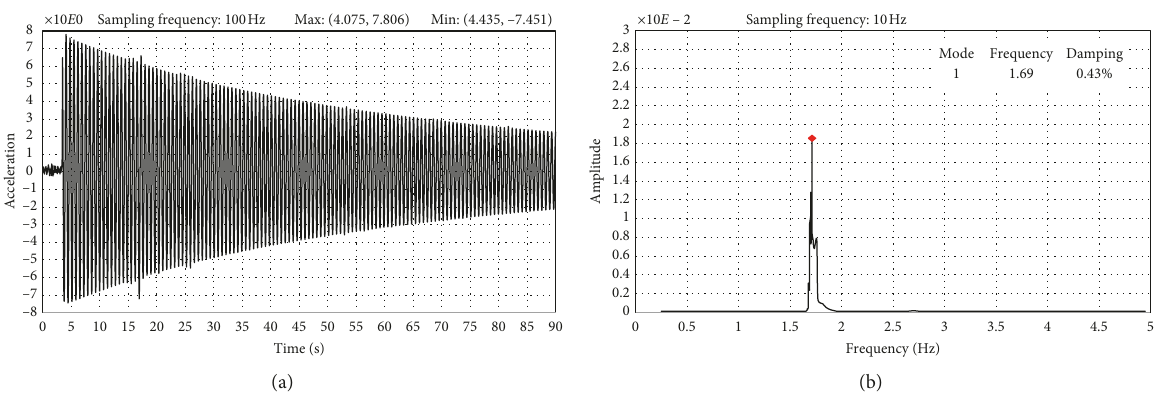
Figure 16: Monitoring results without the particle damper. (a) Acceleration-time history curve of the frame. (b) Identified frequency and damping ratio.